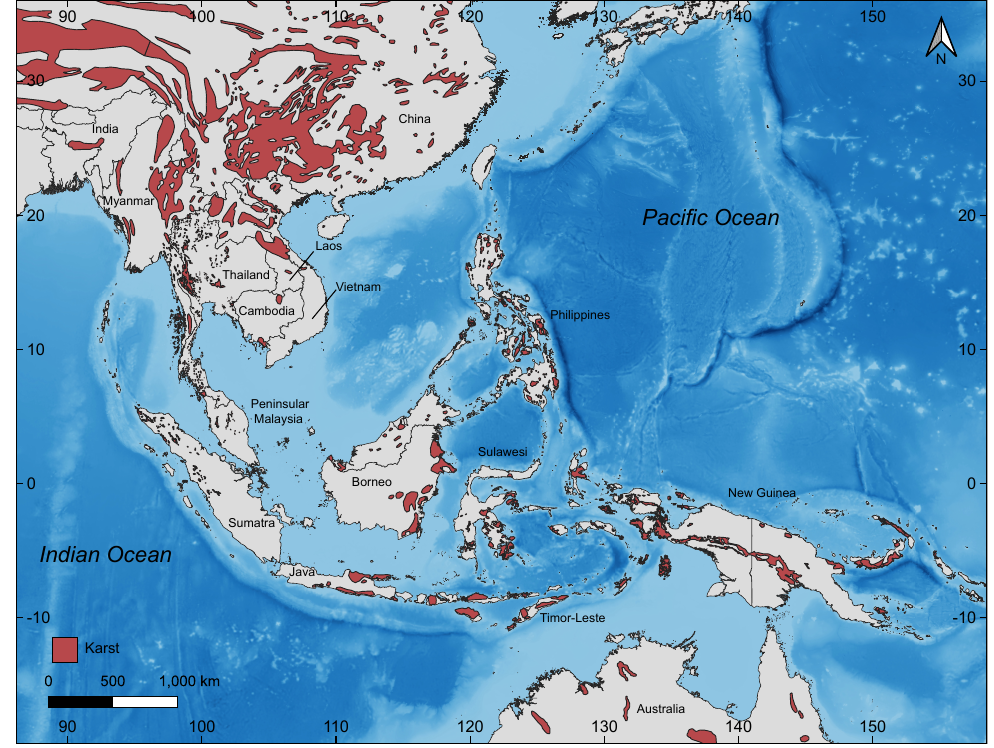
Figure 2. The distribution of karstic landscapes throughout Indochina and the Indo- Australian